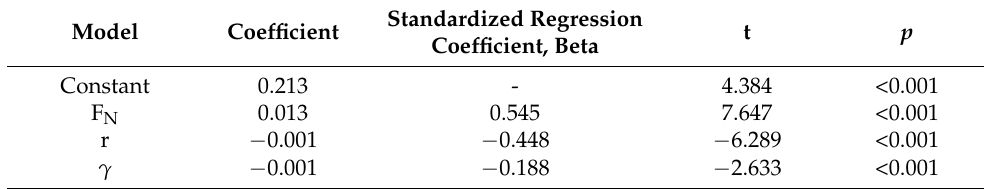
Table 6. Coefficients of the regression model for Dp in single-asperity scratch test. Model